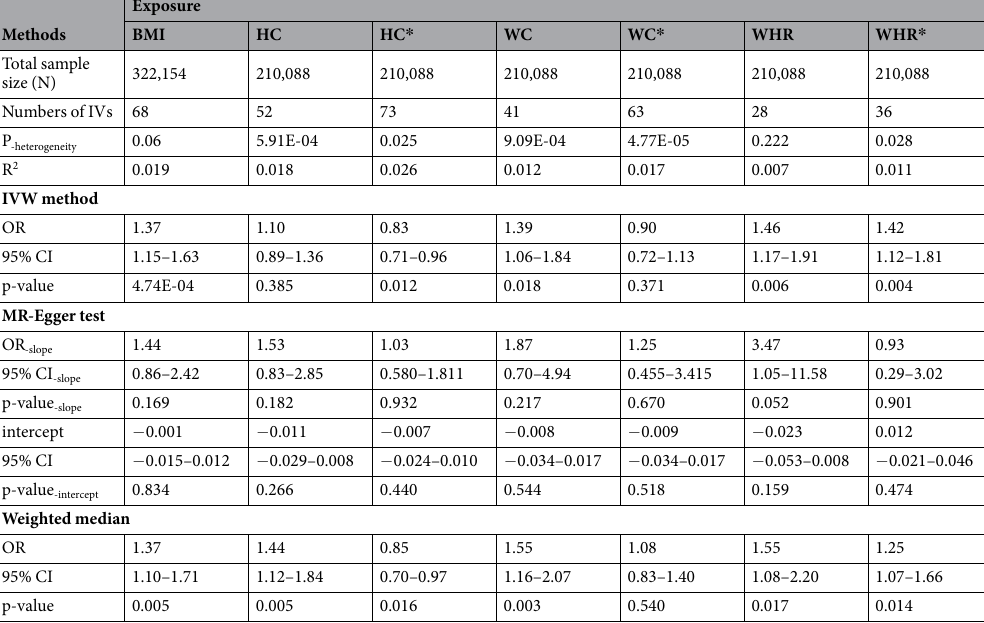
Table 1. Causal estimates of the association of obesity-related traits on risk of CAD. * Indicates that this trait was adjusted for body mass index (BMI) in our study. R 2 refers to the proportion of variance of the exposure explained by the instruments. Hip circumference (HC), waist circumference (WC), waist-hip ratio (WHR), odds ratio (OR), confidence interval (CI), instrumental variable (IV), inverse variance weighted (IVW). In the table, the standard deviations (SDs) for BMI, HC, WC and WHR are 4.770 (kg/m 2 ), 8.455 (cm), 12.520 (cm) and 0.074, respectively. OR means that the change in odds in CAD with a 1-SD increase in each obesity-related trait. P-heterogeneity is derived from the Q statistic, and p-intercept is derived from the MR-Egger